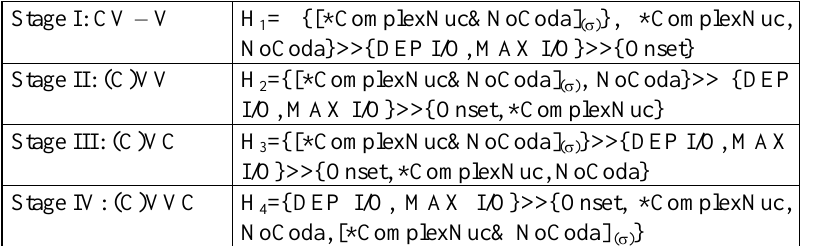
Table VII – Acquisition of syllable structure in Brazilian